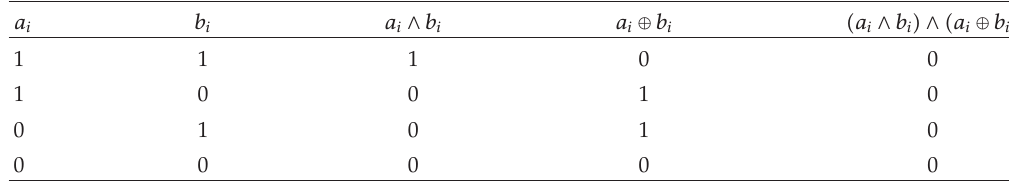
Table 4: Showing calculation of